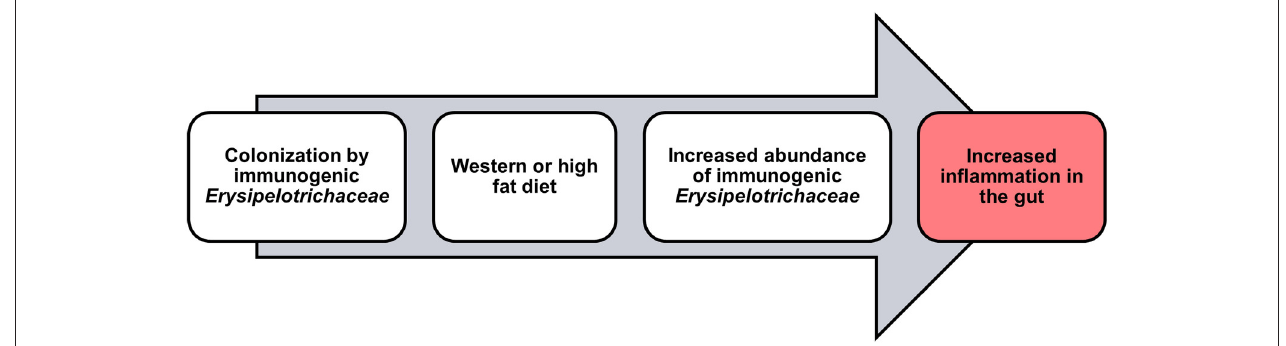
FIGURE 1 | Potential role for Erysipelotrichaceae in inflammation within the